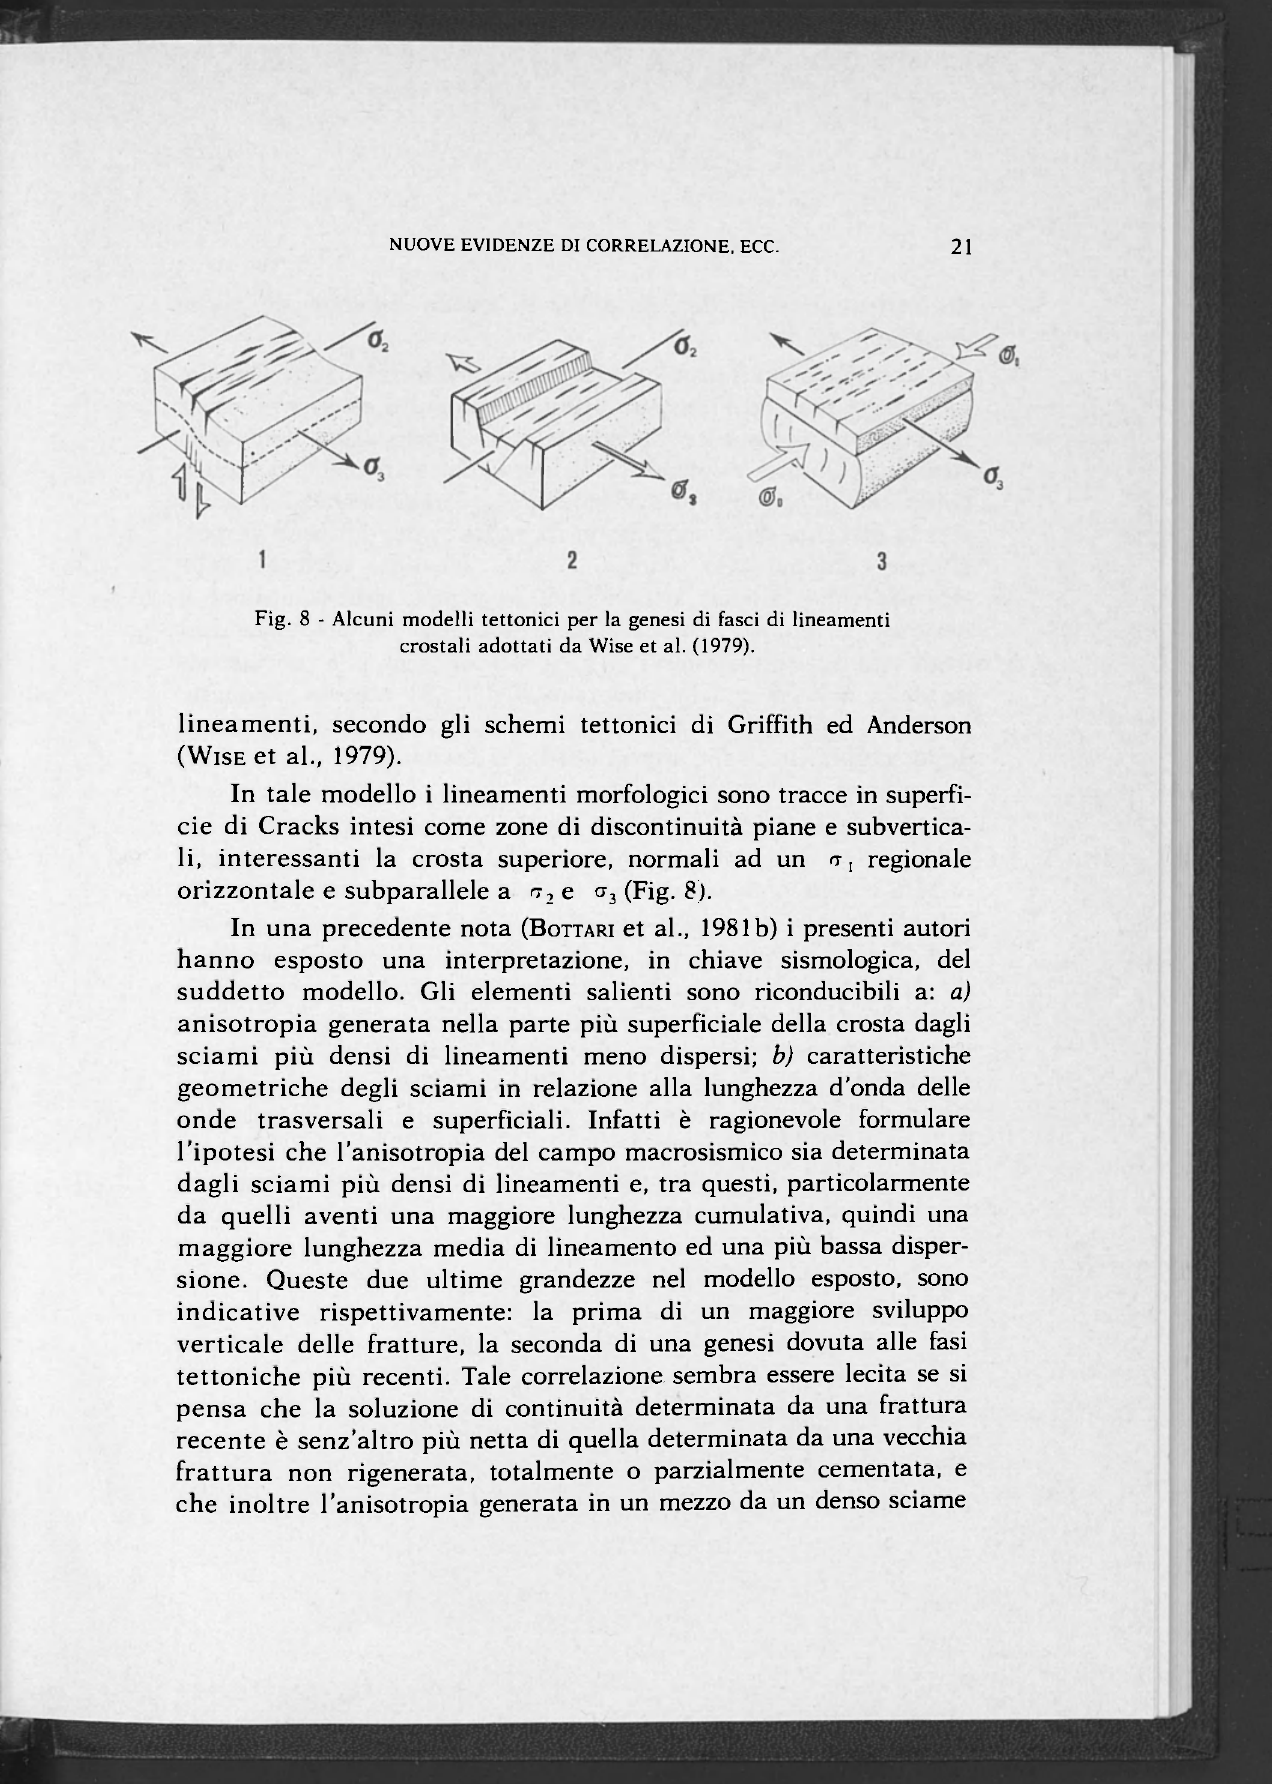
Fig. 8 - Alcuni modelli tettonici per la genesi di fasci di lineamenti crostali adottati da Wise et al.